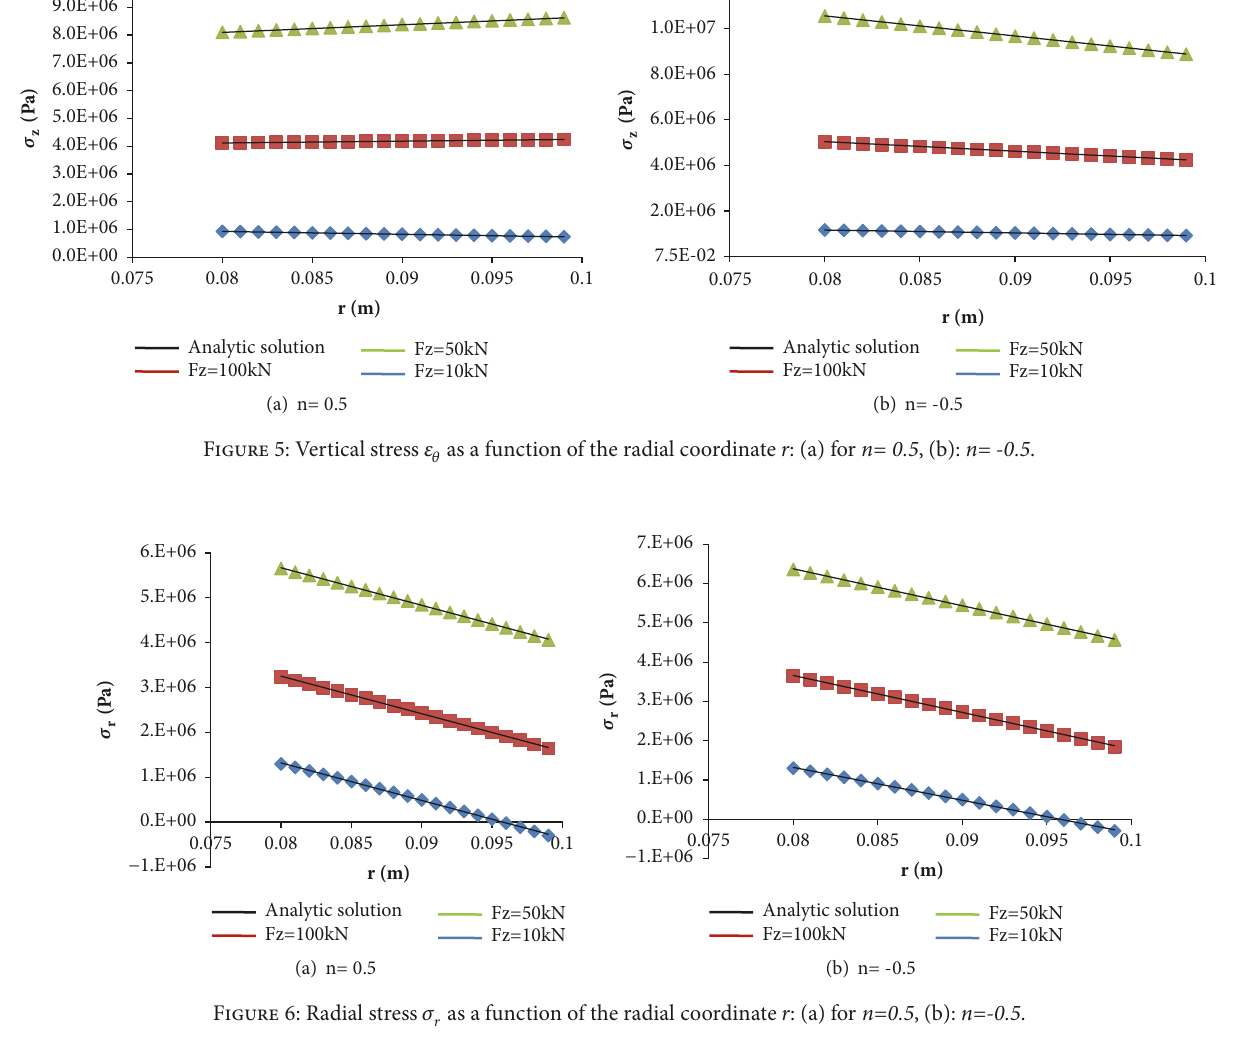
Figure 6: Radial stress 𝜎 𝑟 as a function of the radial coordinate r : (a) for n=0.5 , (b): n=-0.5 .